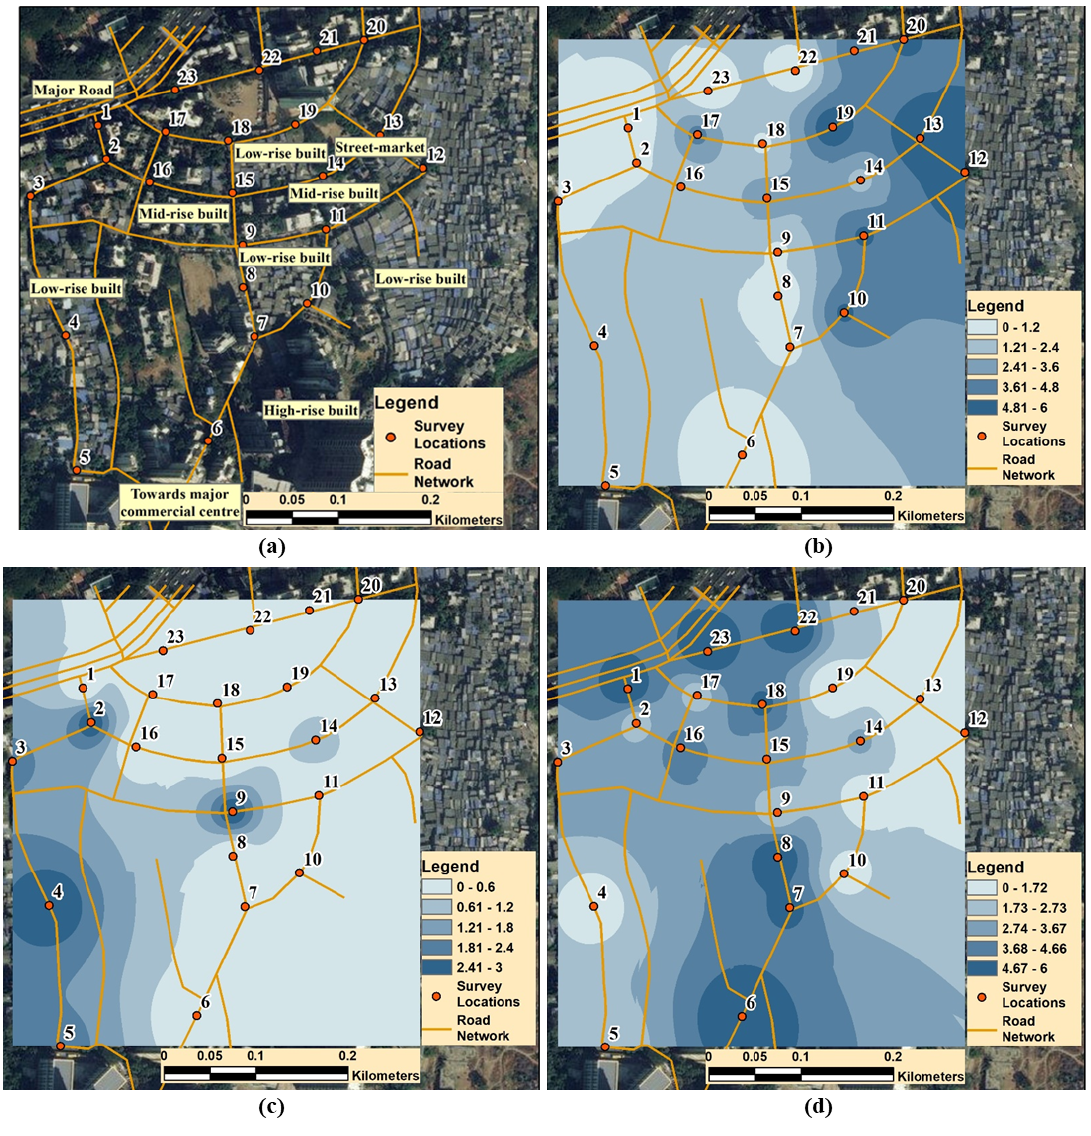
Figure 5: (a) Study area and locations of audio data collection. (b) IDW model showing the presence of Human-based sounds. (c) IDW model showing the presence of Biotic sounds. (d) IDW model showing the presence of Anthropogenic